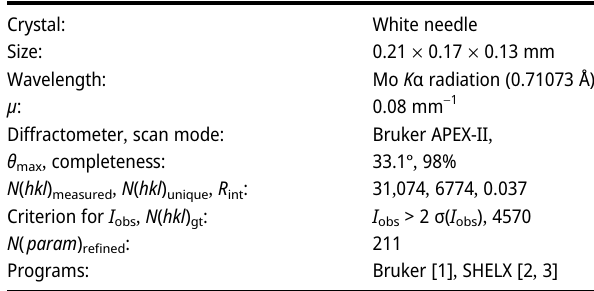
Table  : Data collection and